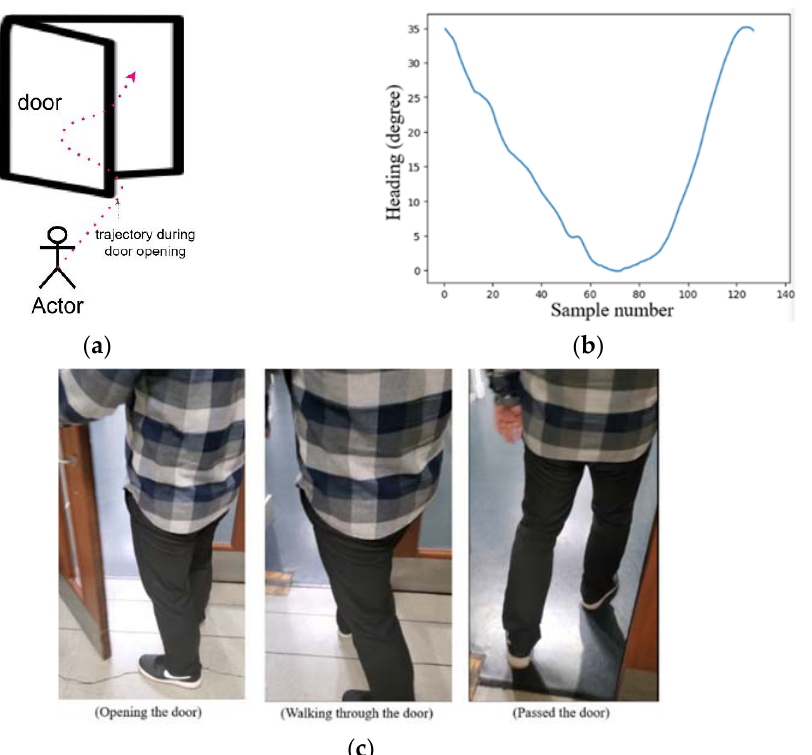
Figure 6. Fluctuation of the magnitude of accelerometer for door opening and normal walking.